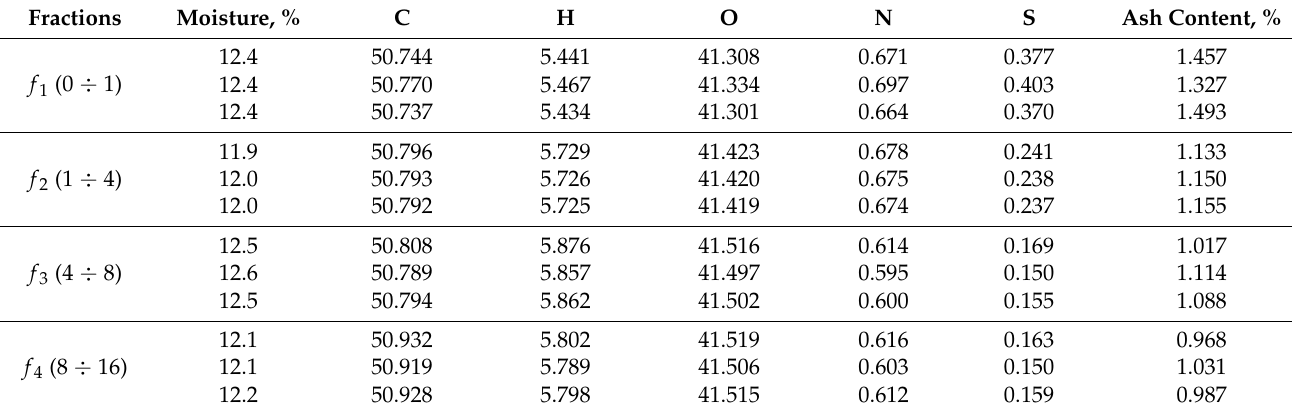
Table 1. Mineral compounds and moisture